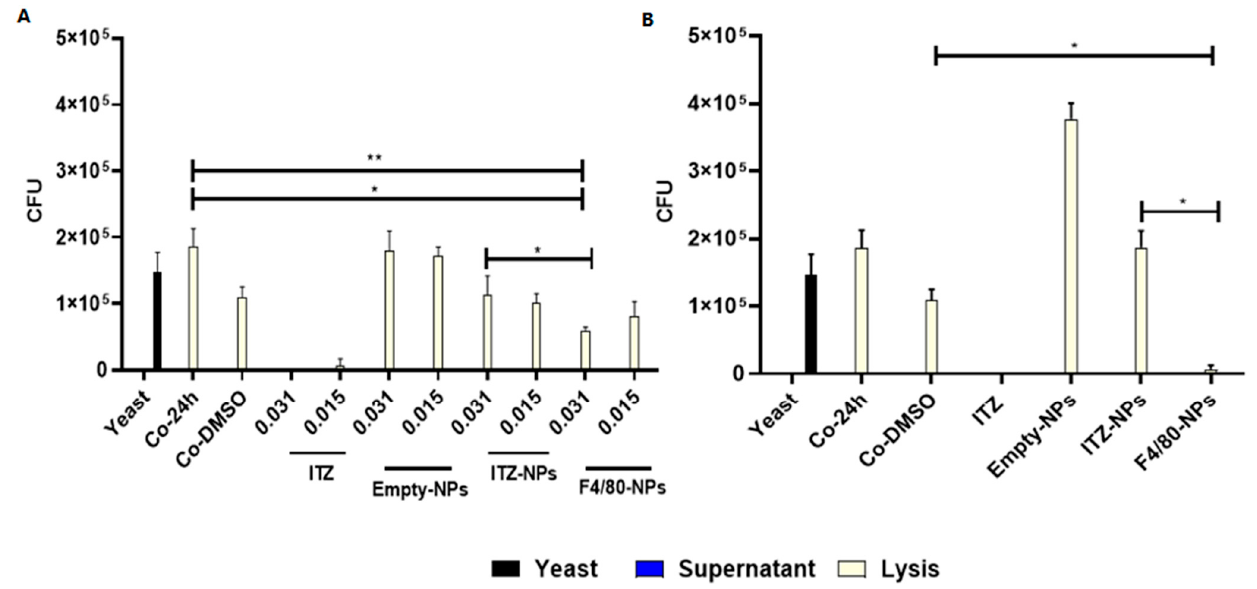
Figure 4. The efficiency of ITZ encapsulated into PLGA75:25-TPGS-pH5 NPs functionalized with the anti-F4/80 antibody to eliminate H. capsulatum yeast in co-culture (Co) with ( A ) J774A.1 by CFU counting of phagocytosed (lysed) or non-phagocytic yeasts (supernatant) after the treatment with 0.031 and 0.015 µg/mL of NPs with or without ITZ and free ITZ for 24 h ( B ) J774A.1 CFU counting of yeasts after the treatment with 0.007 µg/mL of NPs with or without ITZ and free ITZ for 6 h. *, and ** indicate statistically significant differences with p < 0.01, and p < 0.001, respectively.